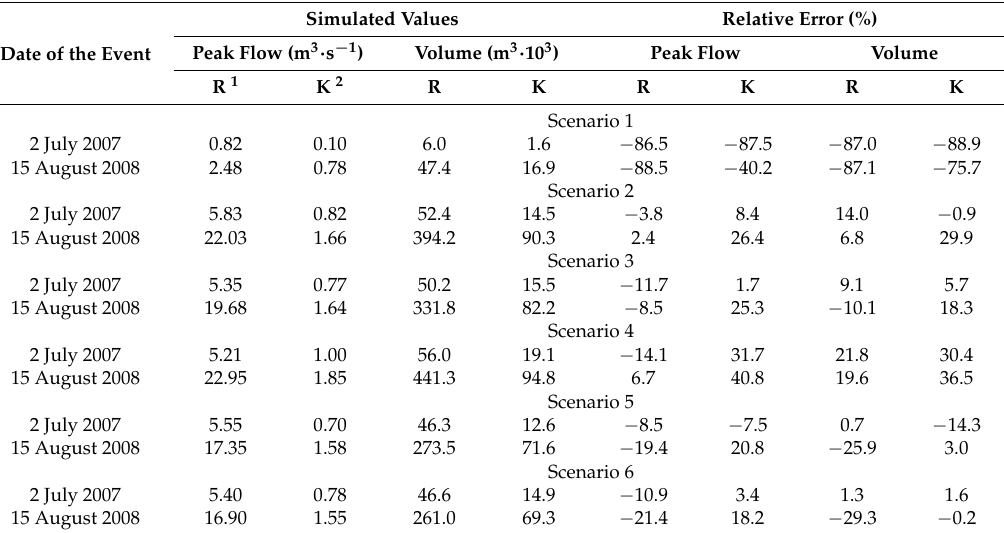
Table 4. Results using rainfall depths estimated from radar